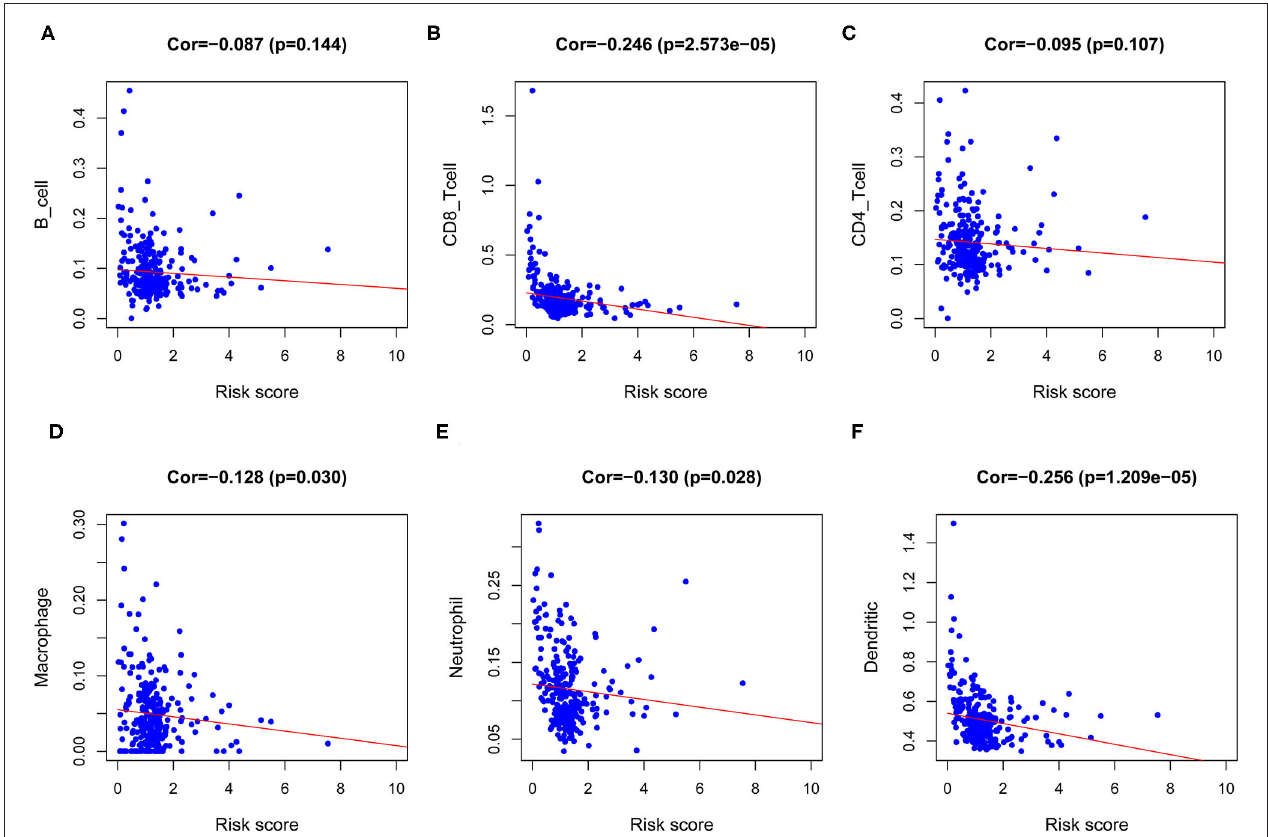
FIGURE 9 | Analysis of the correlation between the risk score and immune cells infiltration. (A) Correlation between risk score and B cell. (B) Correlation between risk score and CD8 T cell. (C) Correlation between risk score and CD4 T cell. (D) Correlation between risk score and Macrophage. (E) Correlation between risk score and Neutrophil. (F) Correlation between risk score and Dendritic